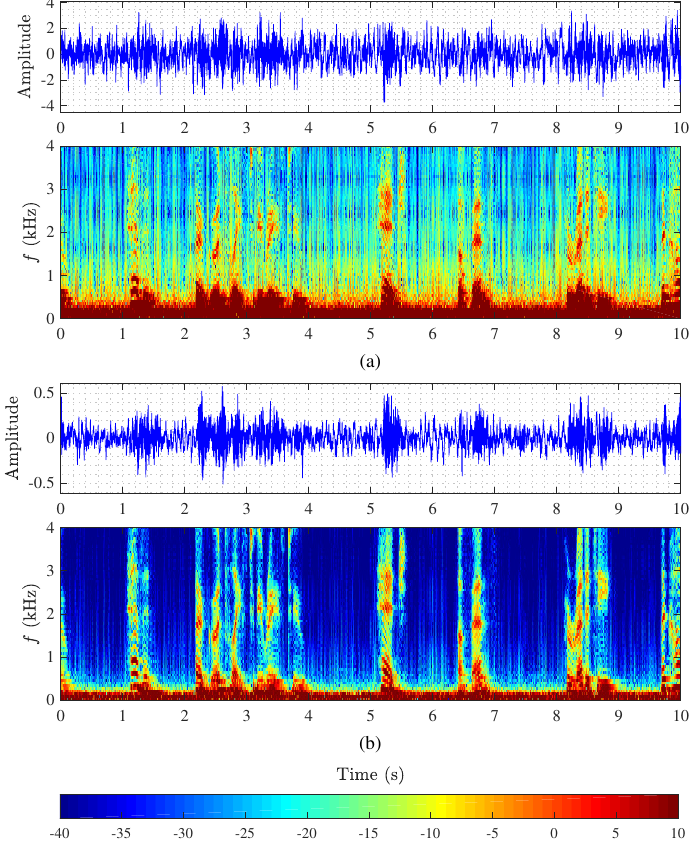
Figure 10. Monaural and binaural superdirective beamformers in a conference room: ( a ) output of the 2nd-order monaural superdirective beamformer and its spectrogram with M = 3 and δ = 1.1 cm, and ( b ) output of the 2nd-order binaural superdirective beamformer and its spectrogram with M = 8 and δ = 1.1 cm.